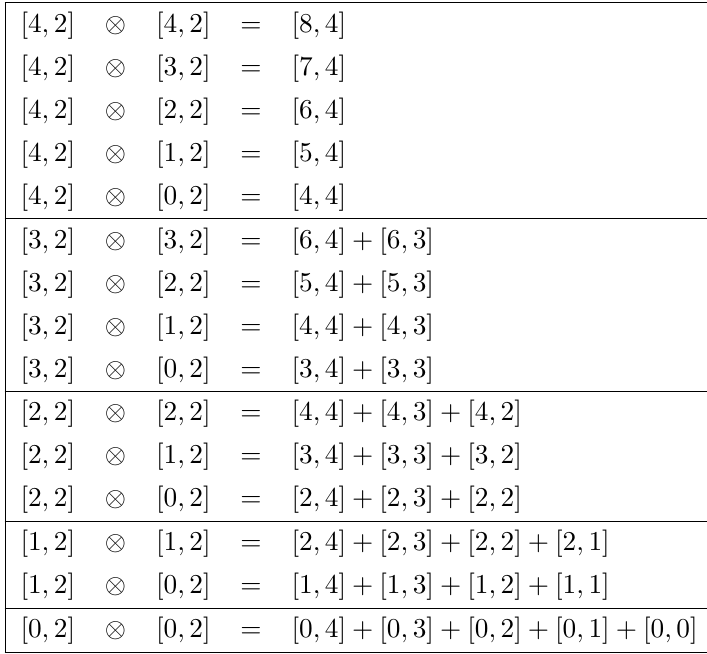
Table 7 . Products of massive spin-2